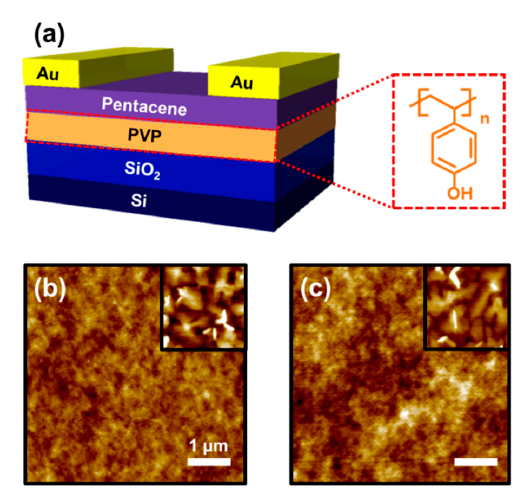
Figure 1. ( a ) Schematic organic phototransistor (OPT) device structure and chemical structure of poly(4-vinylphenol) (PVP). Atomic force microscopy (AFM) images of ( b ) 60 nm-thick and ( c ) 260 nm-thick PVP layers. Inset images present the AFM images of 10 nm-thick pentacene layers on each PVP